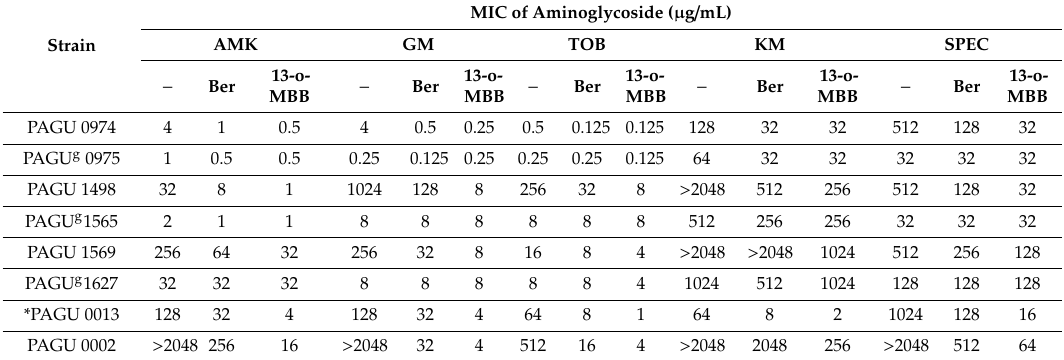
Table 5. Inhibition by 13 − o − MBB of aminoglycoside resistance in P. aeruginosa clinical strains.